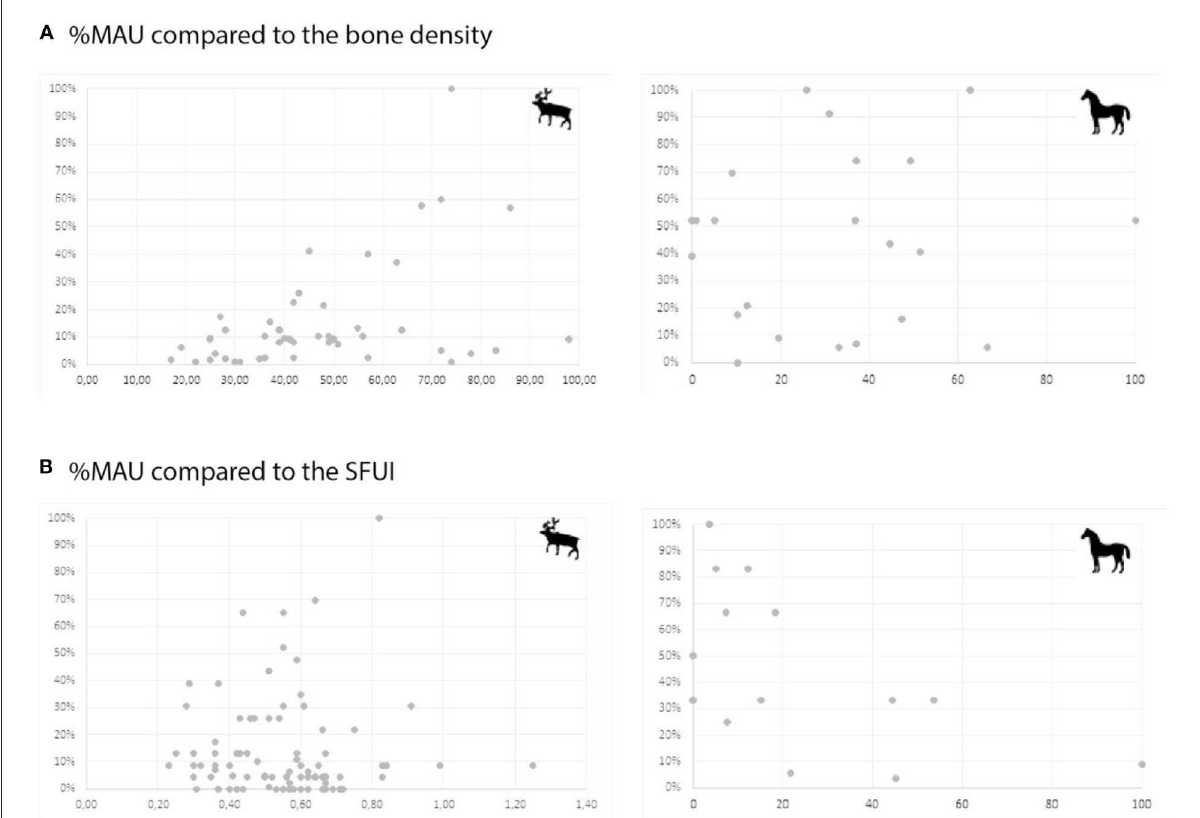
FIGURE7 (A) Differential preservation test: for Reindeer (left) and horse (Right) relative skeletal representation (%NNISP) compared to the bone density (Lam et al., 1999). (B) reindeer (left) and horse (Right) skeletal part representation (y) [in %MAU see Binford (1978, 1981)] compared to their nutritive value (x) expressed in SFUI (Outram and Rowley-Conwy,